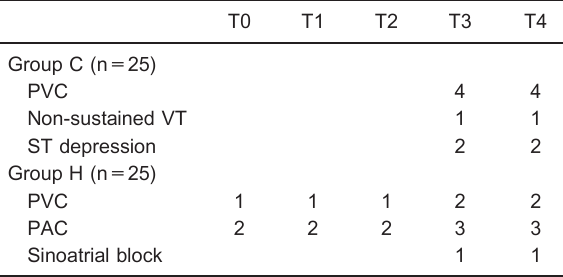
Table 3. ECG abnormalities observed in groups C and